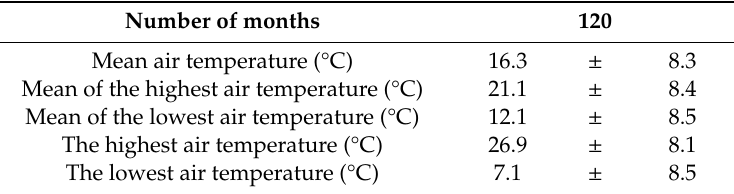
Table 1. Climate parameters from 2007 to 2016 in Gifu prefecture, Japan.